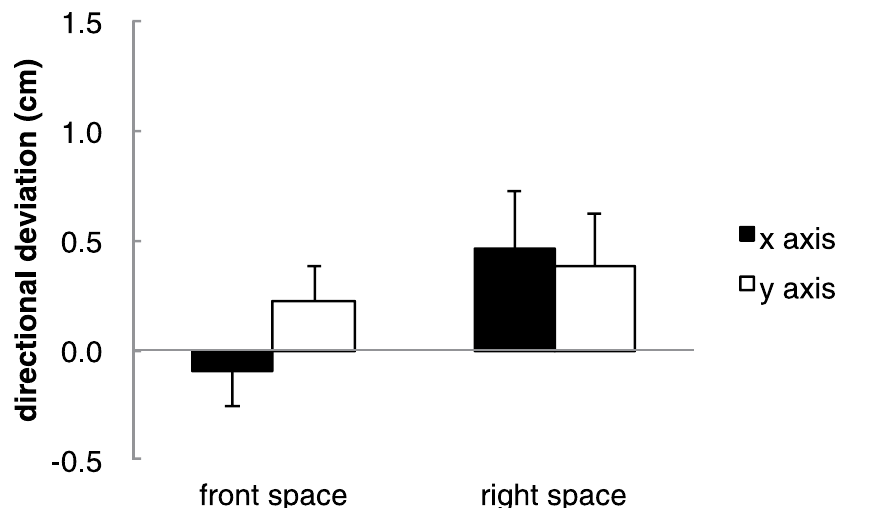
Fig 9. Mean directional deviations for each axis in each space for the table hidden group. Error bars show SE .